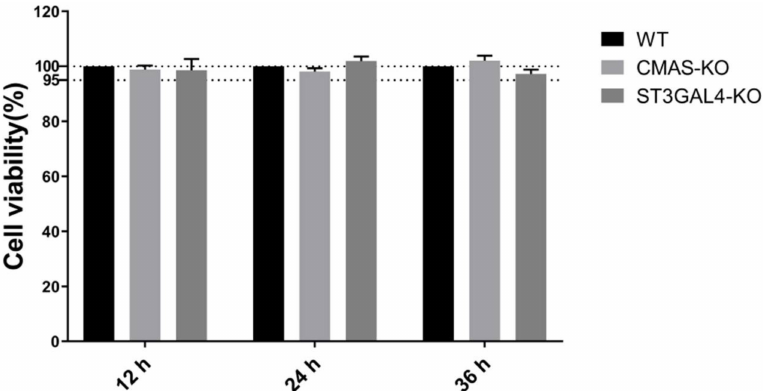
Figure 2. Knockout of CMAS or ST3GAL4 has no effect on cell viability. CMAS -KO and ST3GAL4 -KO NPTr cells were generated through the CRISPR/Cas9 system; NPTR-Cas9 cells were used as wild- type control. WT NPTr cells and KO NPTr cells were seeded in 96-well plates and the cell viability was measured at 12, 24 and 36